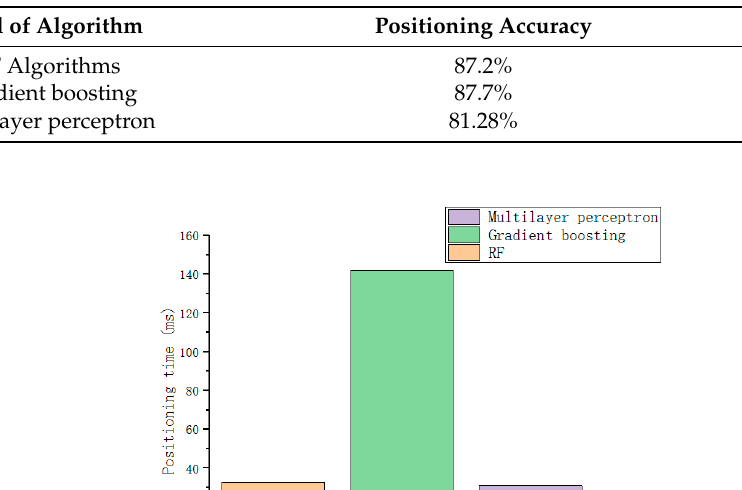
Table 3. Algorithm accuracy comparison.